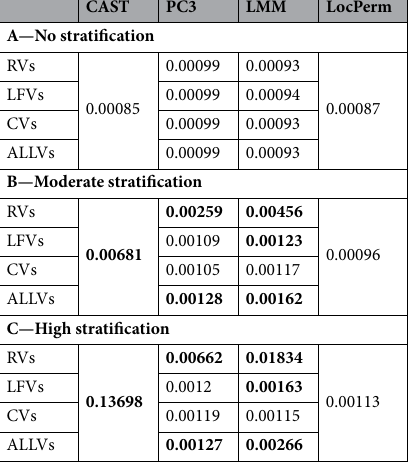
Table 2. Type I error rates of the different approaches for the large Worldwide sample. The nominal level alpha considered is α = 0.001 and the corresponding 95%PI adjusted for the 10 methods is [0.00079–0.00121]. Type I error rates under the lower bound of the 95%PI are displayed in italic and above the upper bound of the 95%PI in